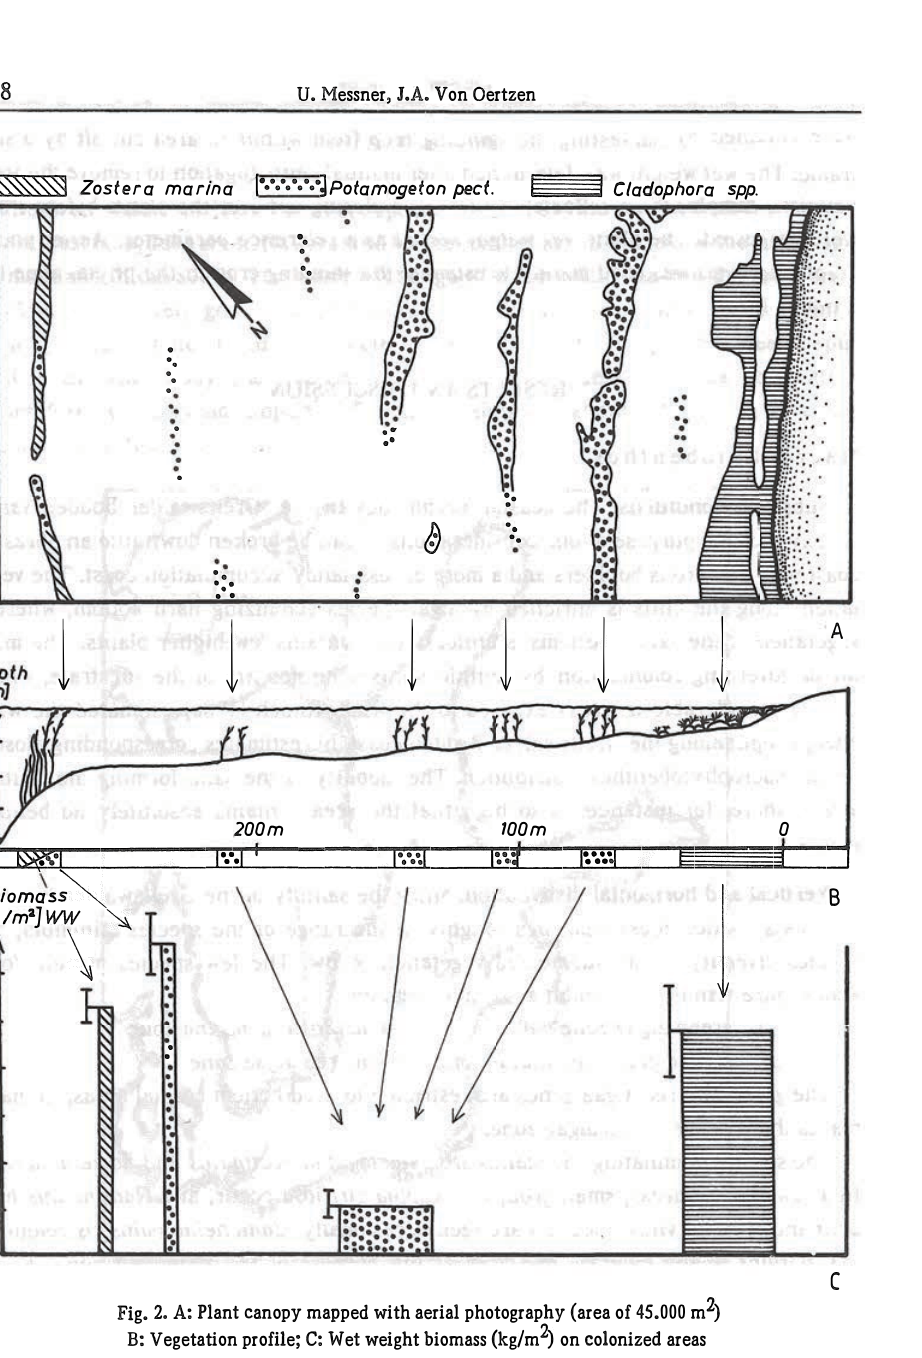
Fig. 2. A: Plant canopy mapped with aerial photography (area of 45.000 m2) B: Vegetation profile; C: Wet weight biomass (kg/m2) on colonized areas